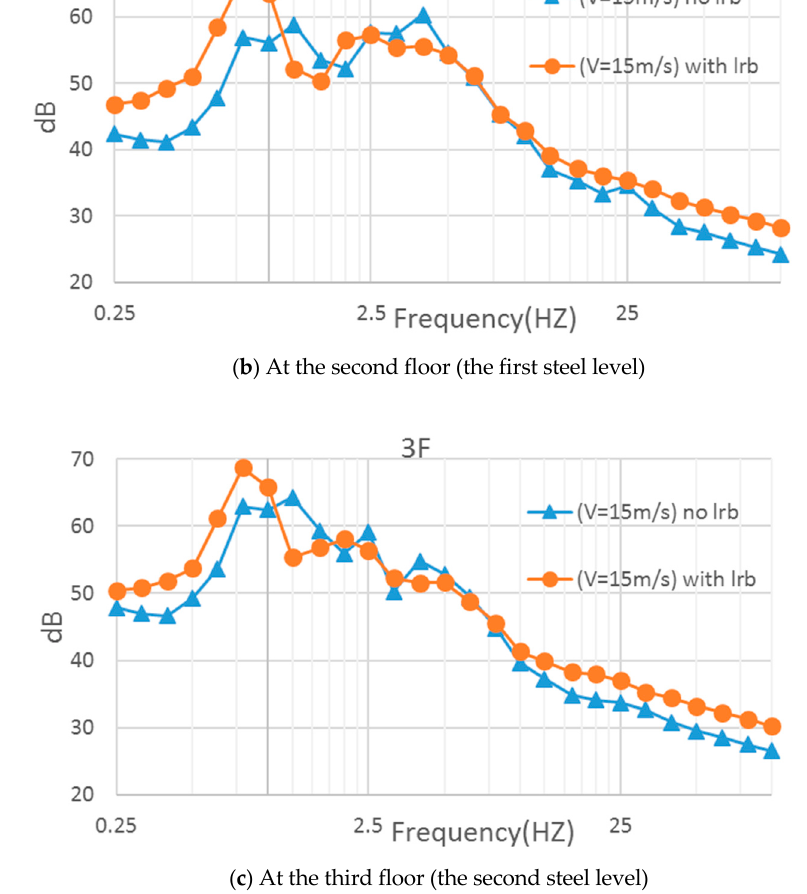
Figure 12. Velocity vibration dB at the first to third floors under the wind load with the average wind speed of 15 m/s for the factory with or without LRBs.